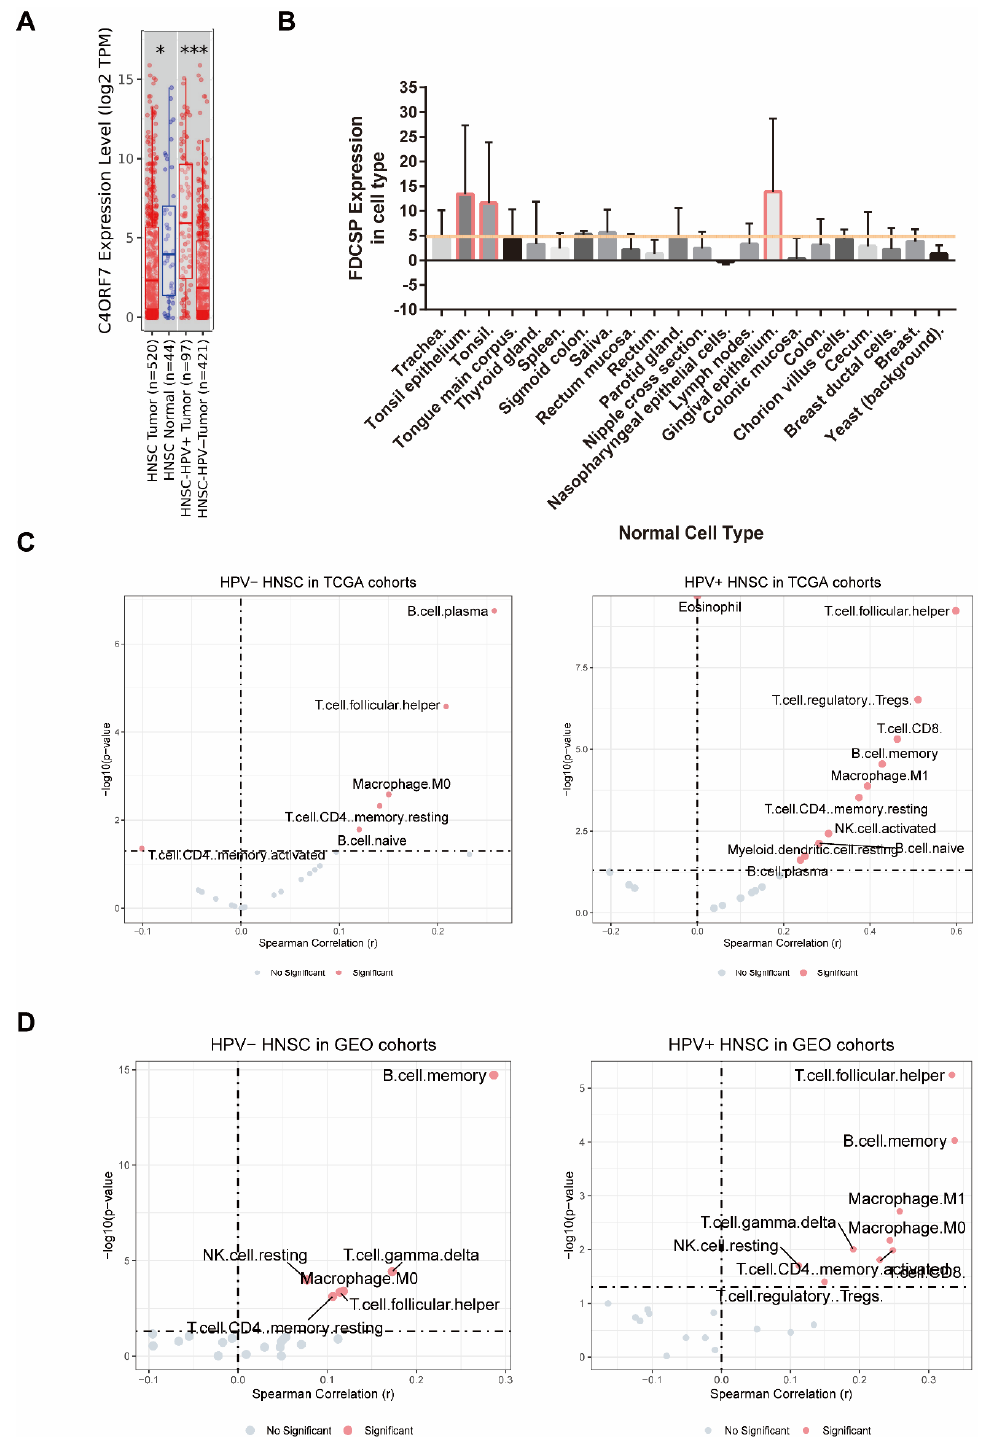
Figure 3. The relationship between FDCSP and immune cells in HNSC. ( A ) Expression of FDCSP in HSNC (from Timer2.0 database, grouped by HPV status, A z-score >5 suggests that the gene is expressed in that tissue). ( B ) FDCSP expression in human normal tissues. ( C ) Correlation between FDCSP expression and immune cell types in TCGA-HNSC cohorts (CIBERSORT_ABS). ( D ) Correla- tion between FDCSP expression and immune cell types of HNSC in GEO cohorts (CIBERSORT_ABS). ( x -axis: Spearman Correlation(r), y -axis: -log10(p), Dotted line as dividing line: x at 0 and y at 1.301). *: p value<0.05, ***: p